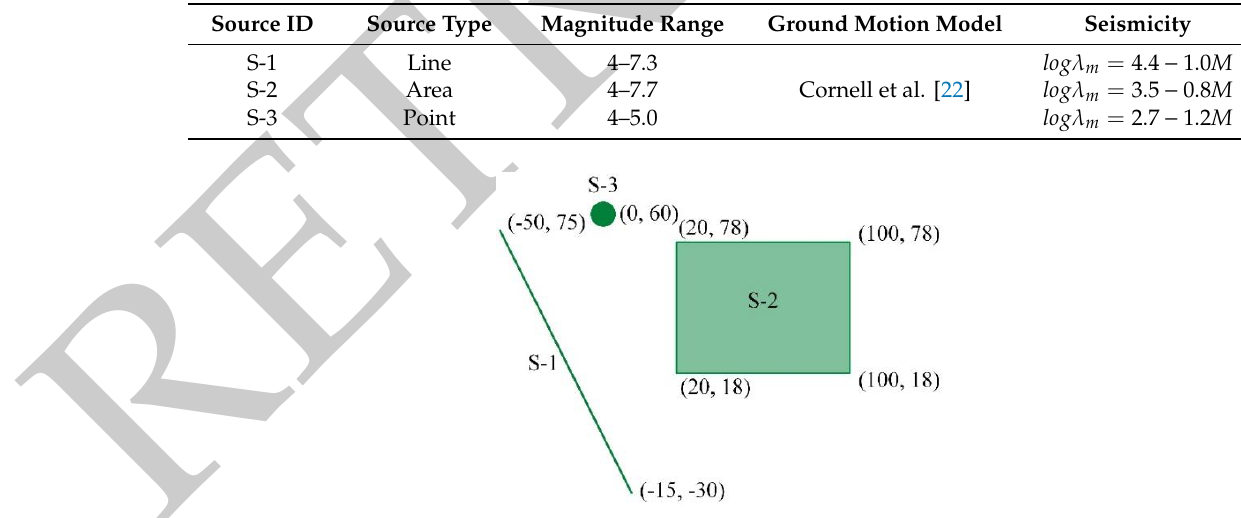
Figure 5. A seismic site with three different sources.